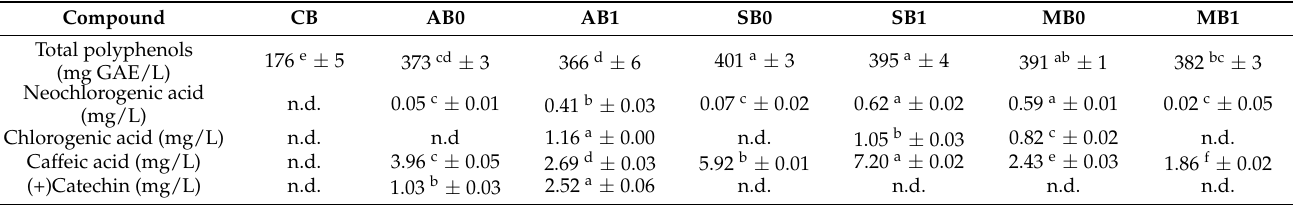
Table 3. Contents of polyphenols and polyphenolic profile of fruit